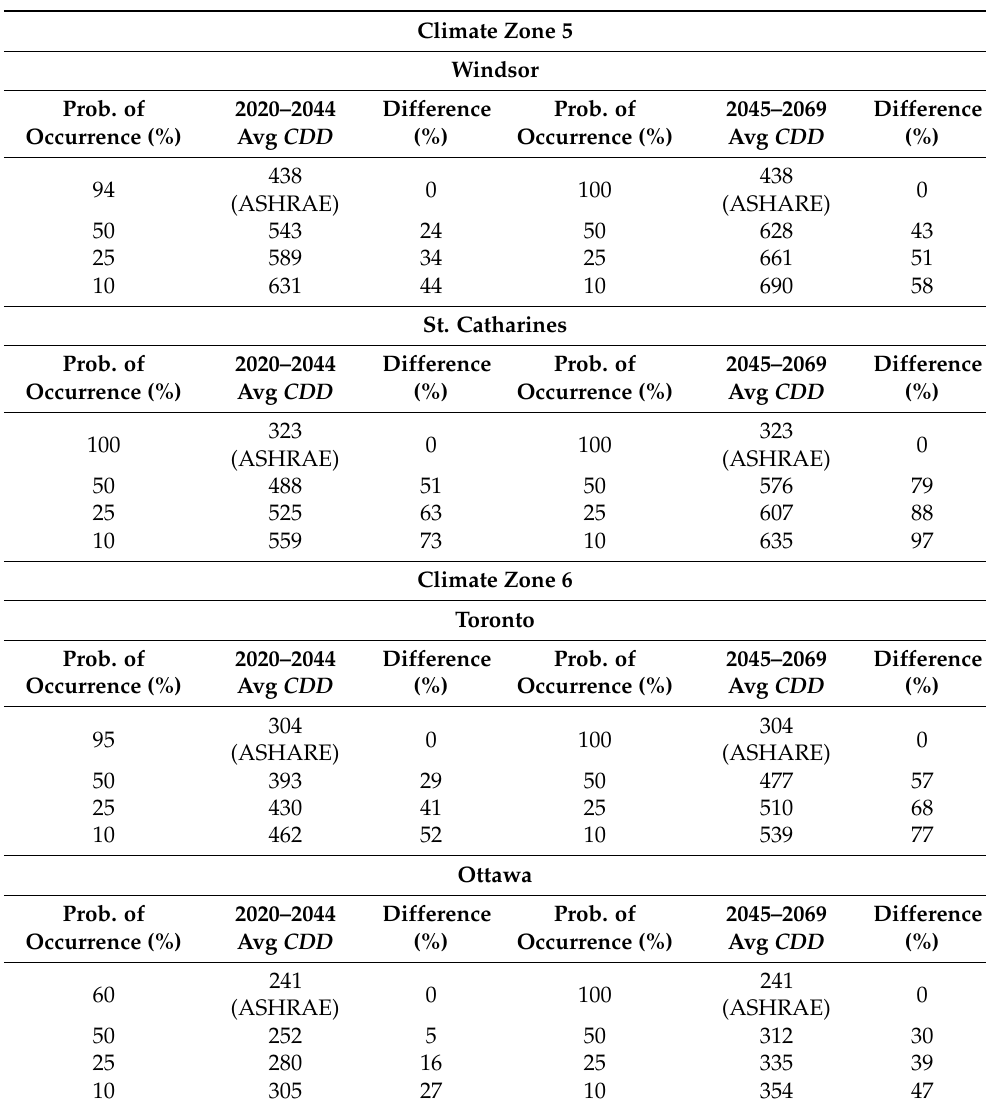
Table 7. The probability of future CDD exceeding the ASHRAE CDD design conditions (2020–2044 average and 2045–2069